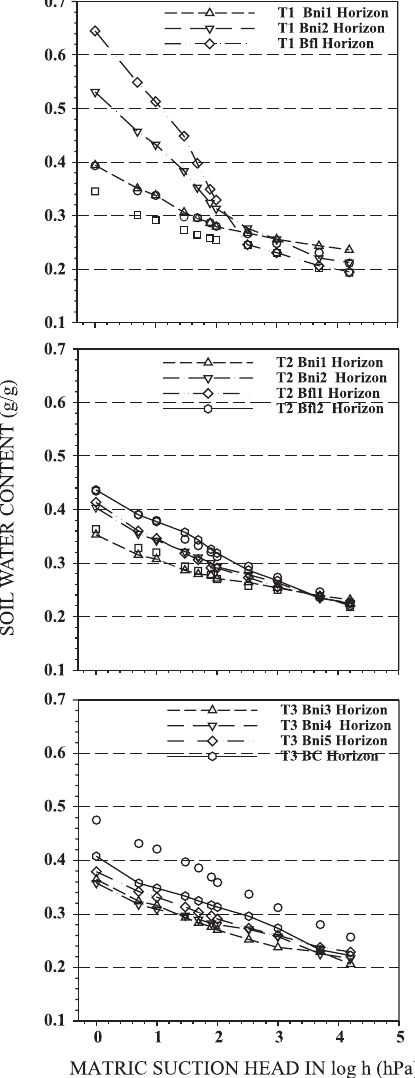
Figure 5. Soil water characteristic curves of each profile (T1, T2 and T3).